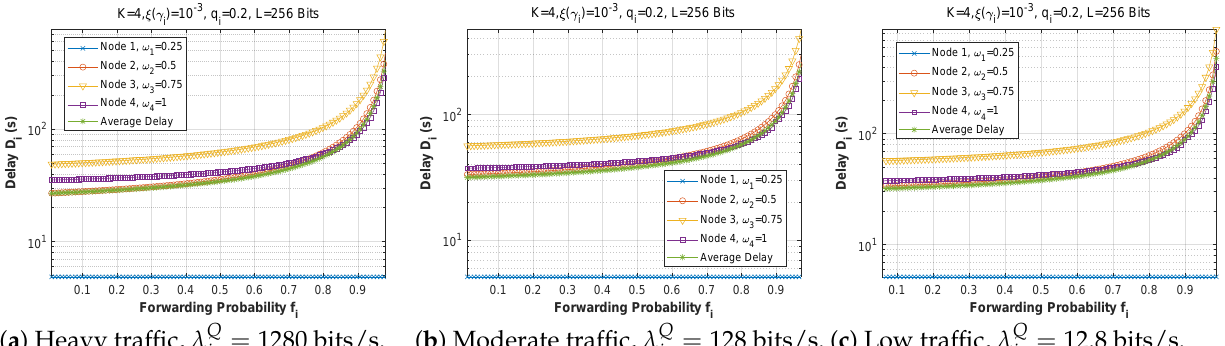
Figure 11. Setting 3: The delay experienced at each mobile device when varying the forwarding probability with the arrival rate λ Q i